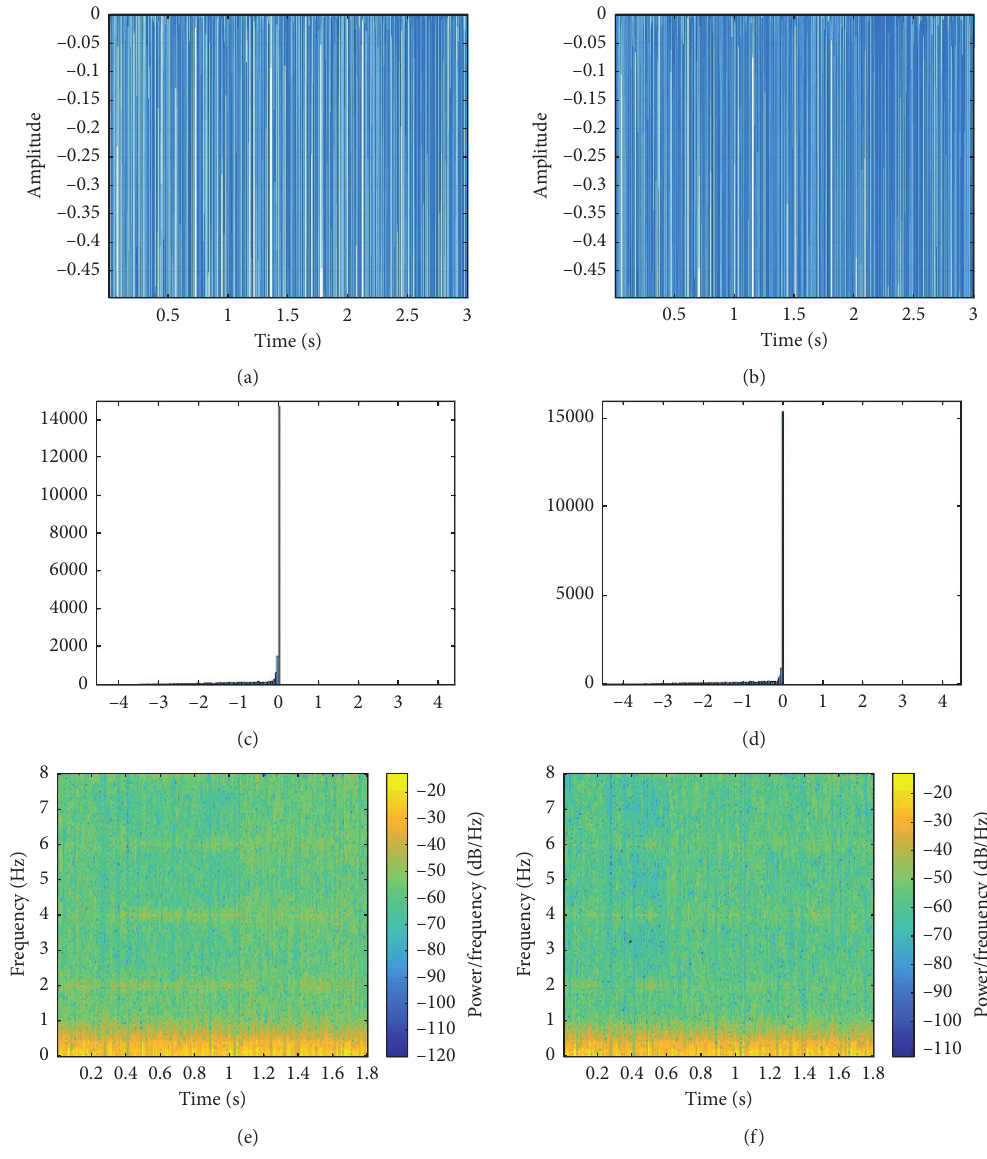
Figure 14: Observed signal: (a) time-domain waveforms of the first observation signal; (b) time-domain waveforms of the second ob- servation signal; (c) histograms of the first observation signal; (d) histograms of the second observation signal; (e) spectrograms of the first observation signal; (f) spectrograms of the second observation